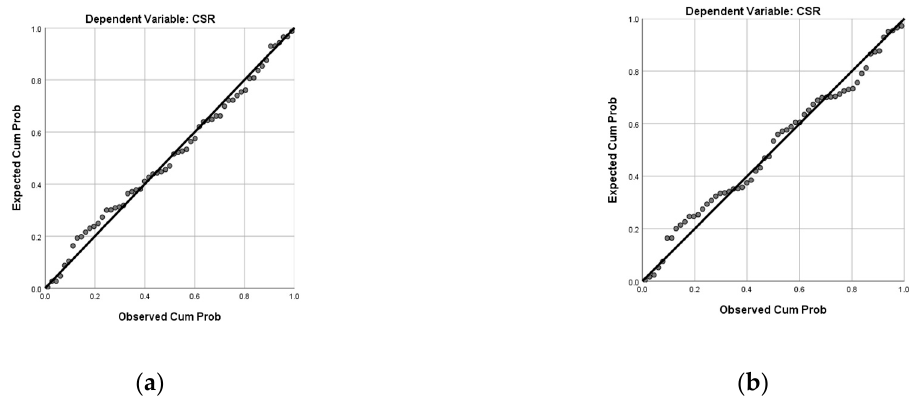
Figure 1. ( a ) Normal P–P plot of residuals for Equation (1); ( b ) normal P–P plot of residuals for Equation (2). Table 6. Regression models